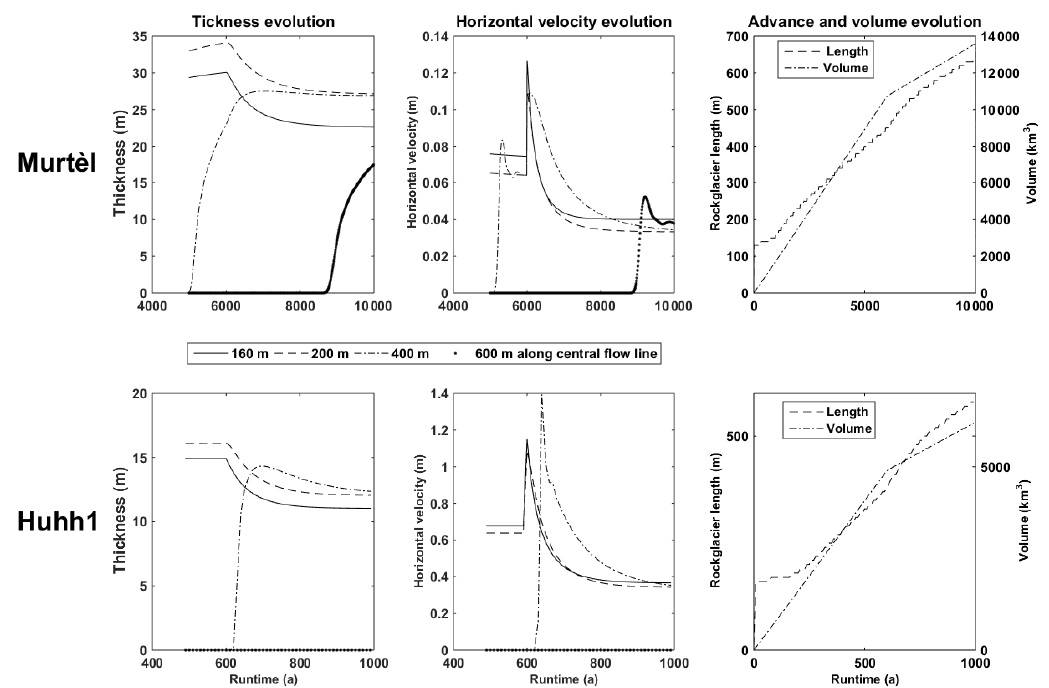
Figure 10. Rock glacier evolution of thickness, horizontal velocity, advance and velocity after a 1 ◦ C temperature increase and 40% decrease in material input after rock glacier buildup. The dynamic evolution is shown for three points along the central flow line at 160, 200 and 400m. The rock glacier is assumed to have an initial temperature of − 1.5 ◦ C